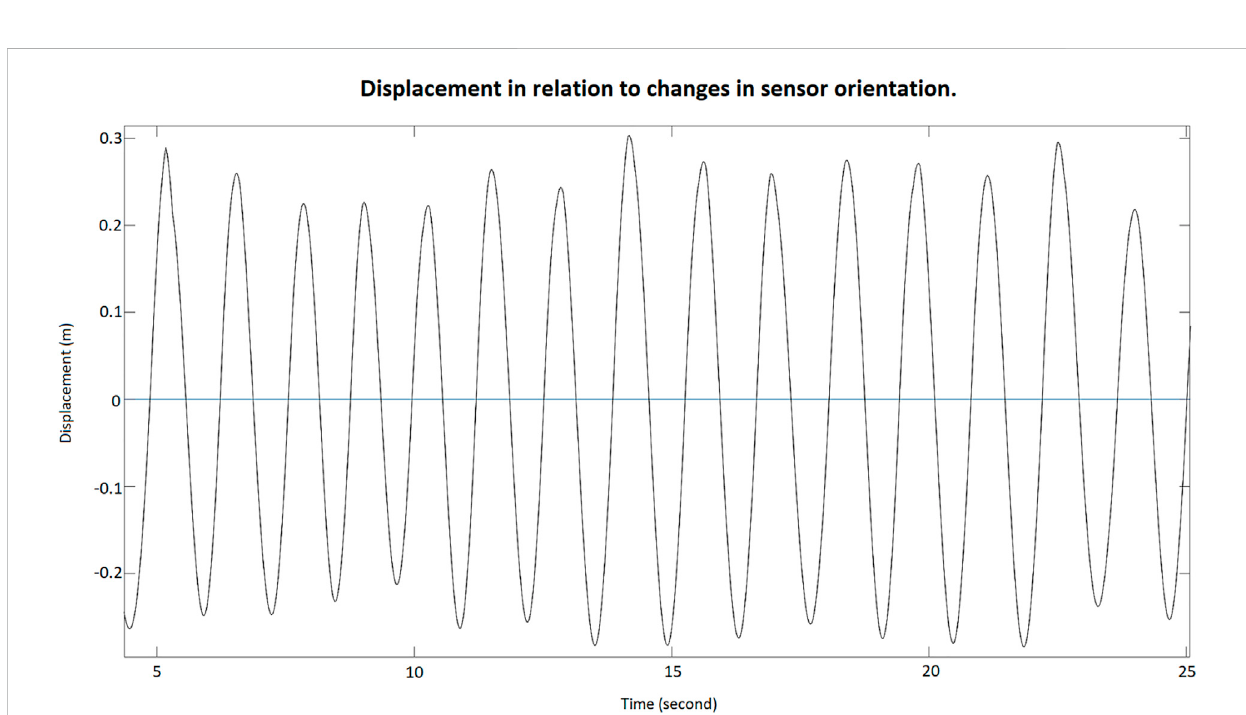
FIGURE 7 Changes in sensor